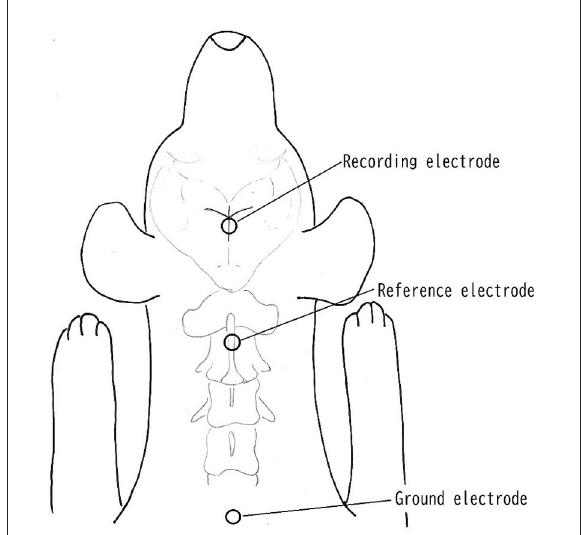
FIGURE1 Placement of electrodes. The recording electrode was placed at the juncture of the coronal and sagittal sutures, which were considered to be adjacent to the somatosensory cortex area. The reference electrode was placed on the spinous process of the axis. The ground electrode was placed on the surface of caudal portion of